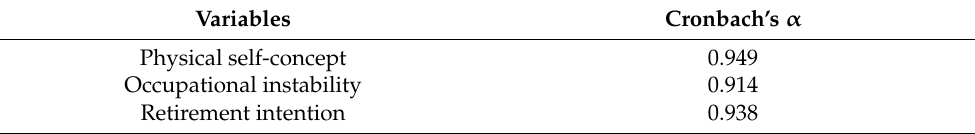
Table 2. Verification of